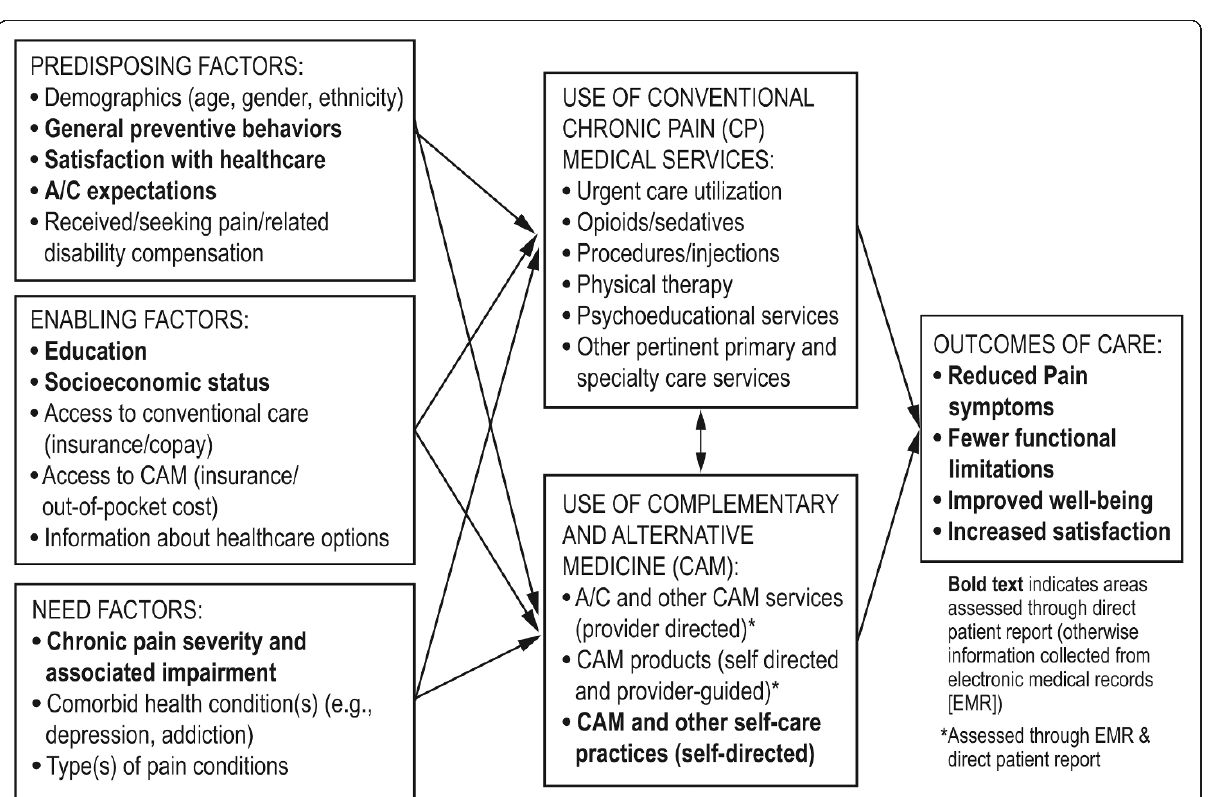
Figure 1 Patient Factors Influencing the Decision to Use Acupuncture and/or Chiropractic Care (A/C) for Chronic Musculoskeletal Pain